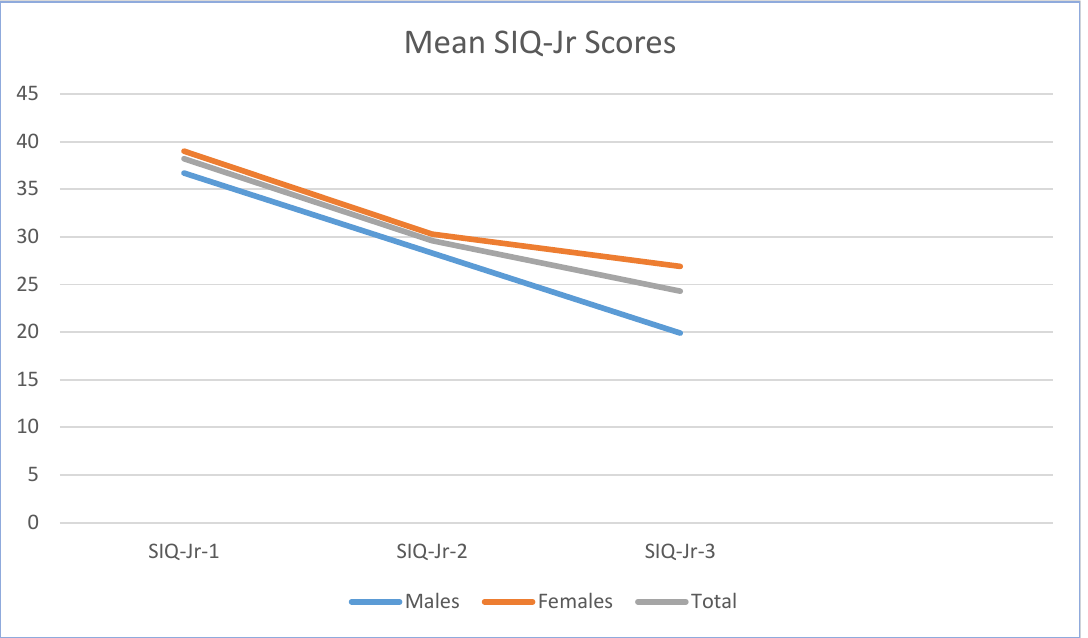
Figure 1. Mean SIQ-JR Scores Over the Course of